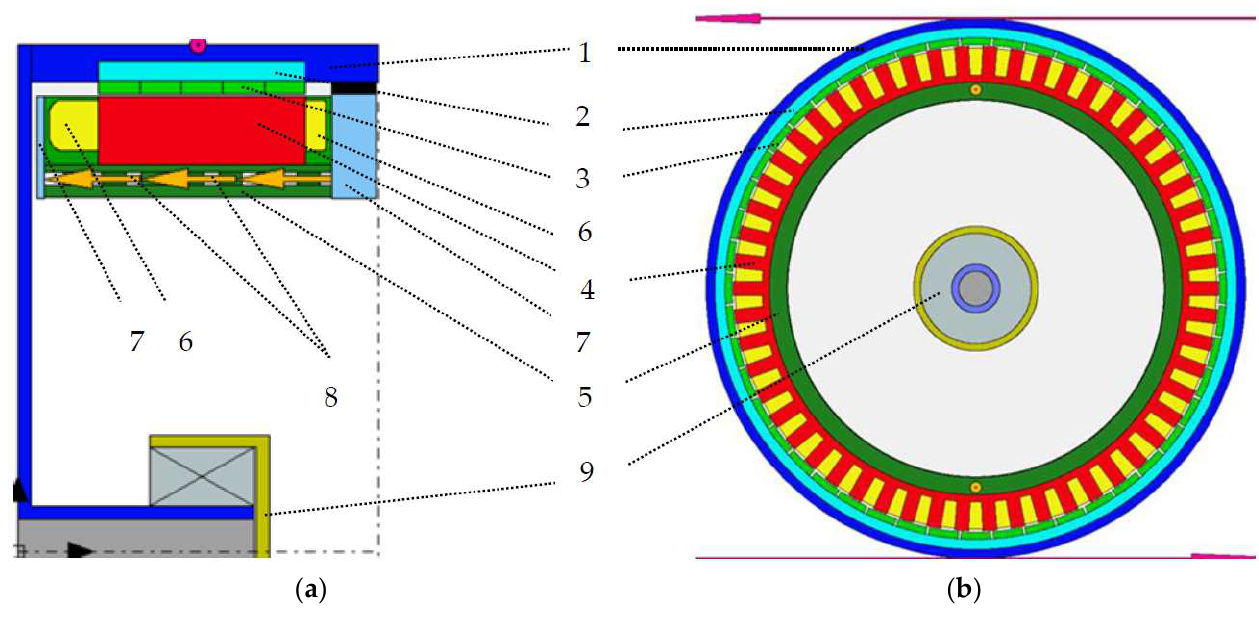
Figure 3. Motor model in Ansys Motor-CAD software ( a ) longitudinal model ( b ) transverse model; 1-rotor, 2-rotor magnetic core, 3-permanent magnets, 4-stator magnetic core, 5-supporting structure, 6–end-winding, 7-side heat sink, 8-channels with flowing coolant, 9-bearing socket.